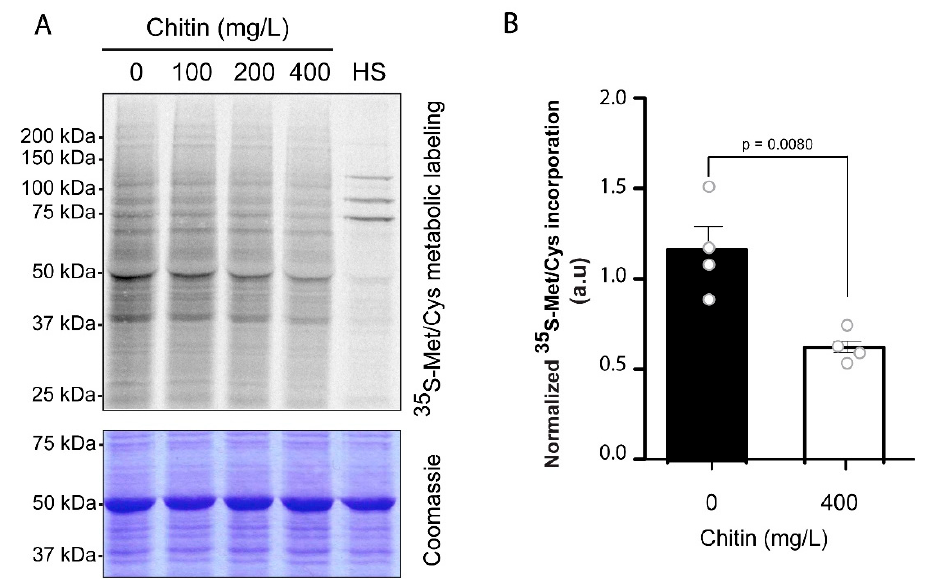
Figure 3. Chitin triggers a global reduction in protein synthesis. ( A ) Metabolic labeling of de novo synthesized proteins. Arabidopsis 7-day-old seedlings were incubated with 35 S-Methionine 35 S-Cysteine in the absence of chitin (-) or in the presence of di ff erent chitin concentrations (upper panel). As positive control of global inhibition of protein synthesis, seedlings were treated at 38 ◦ C for 30 min (HS). The Coomassie staining of the gel is provided as loading control (lower panel). This experiment was repeated at least three times obtaining similar results. ( B ) Normalized quantification of the 35 S-Methionine 35 S-Cysteine incorporation into proteins (related to the total amount of loaded protein per lane) in the absence (-) or in the presence of chitin (400 mg / L). The bars show the mean ± SEM of n = 4 independent experiments. Statistically significant di ff erences ( p < 0.008) were calculated by t -student test.